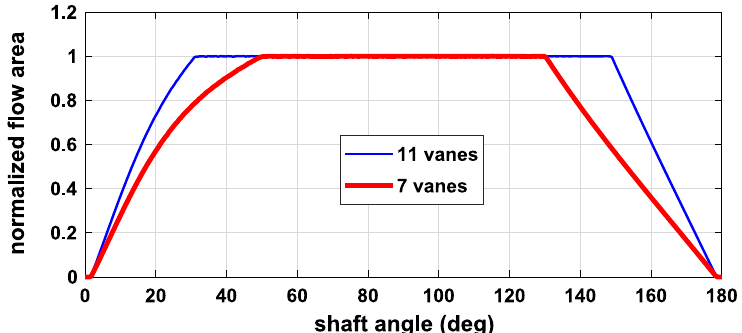
Figure 13. Normalized flow area with seven and 11 vanes. The position of 0 degrees corresponds to the minimum volume of the chamber.